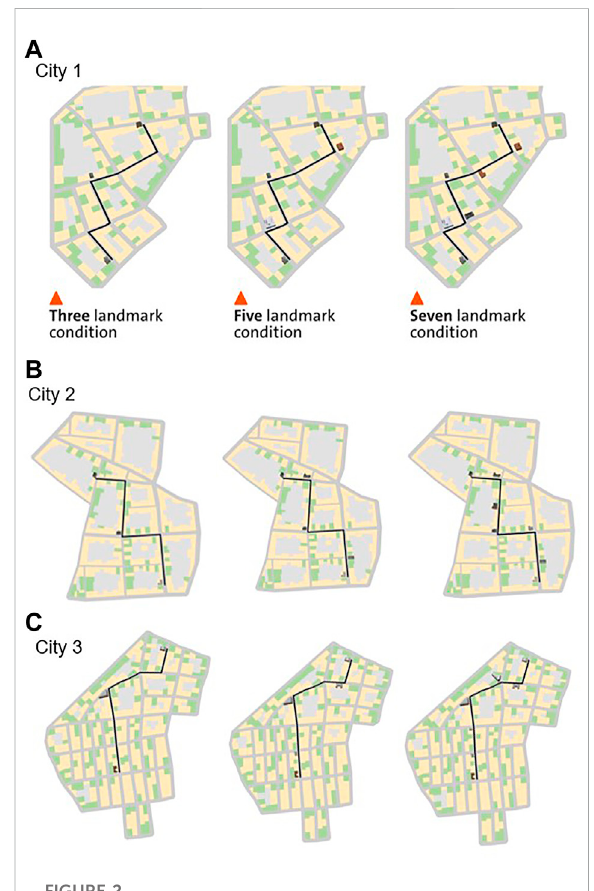
FIGURE 2 The three different landmark conditions in three different virtual environments. The (A – C) depict the map condition with three, fi ve, and seven landmarks displayed on the mobile map,